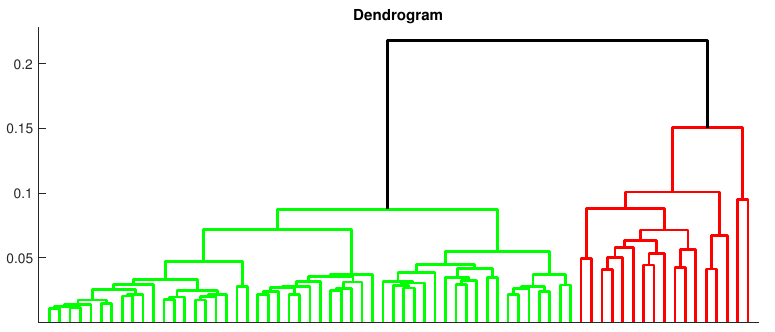
Figure 12. The dendrogram for the spectra corresponding to the 68 segments presents the results of the hierarchical clustering.